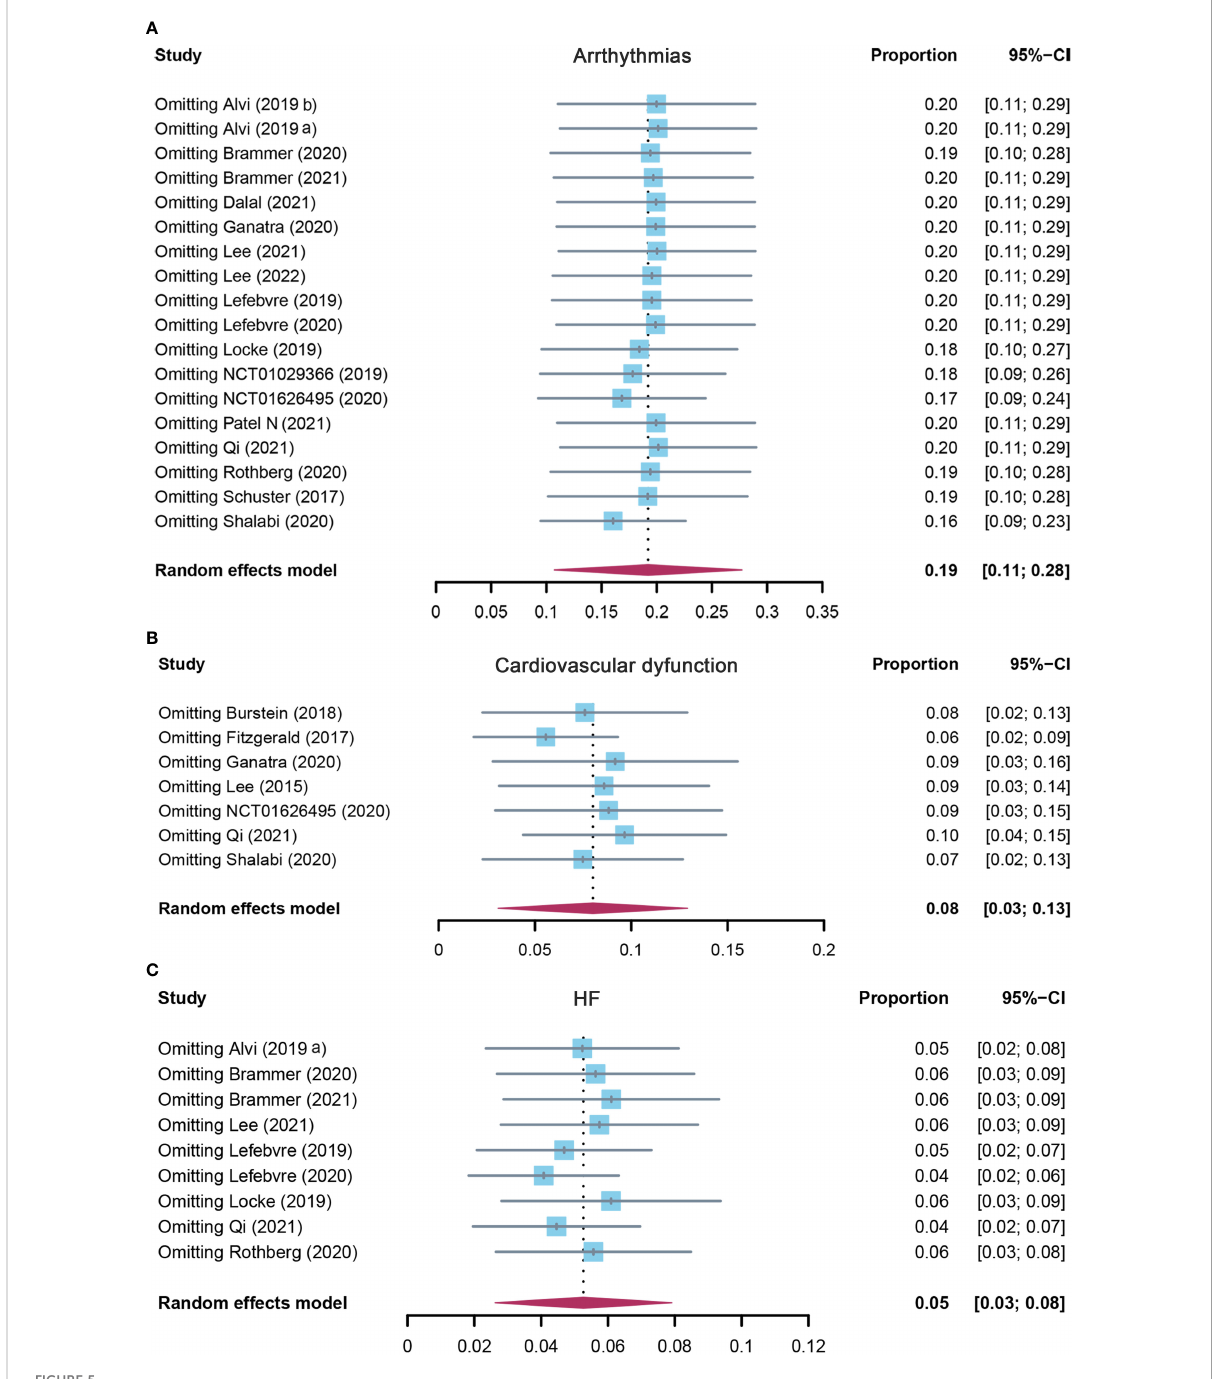
FIGURE 5 The sensitivity analysis of (A) arrhythmias, (B) cardiovascular dysfunction, and (C) HF incidence rate in patients who received CAR-T cell therapy. HF, heart failure; CAR-T cell, chimeric antigen receptor T